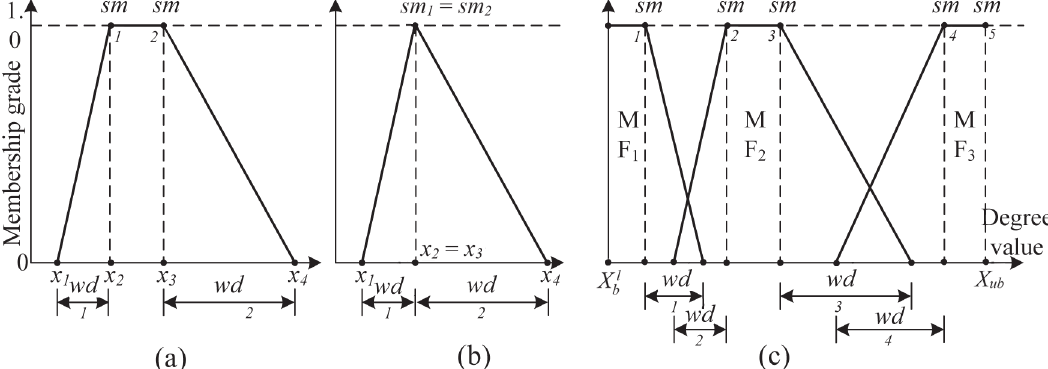
Fig. 3. Membership function: trapezoidal (a), triangular (b), complete MF set (c) (Ko 2002)